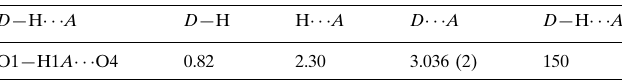
Hydrogen-bond geometry (A˚ , (cid:2)